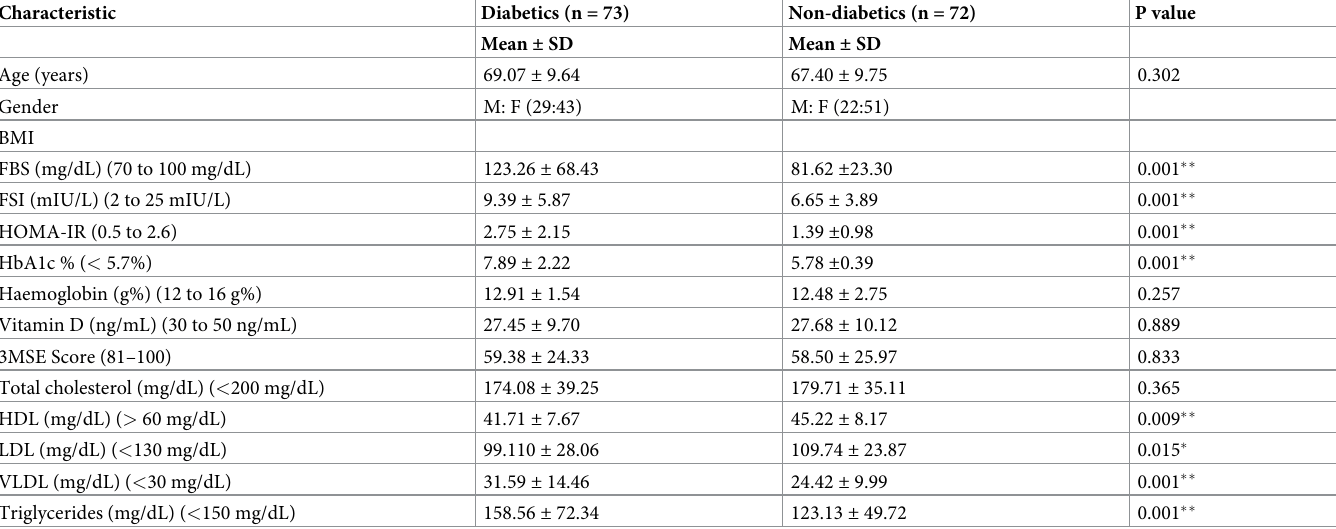
Table 1. Comparison of study participant characteristics between diabetic and non-diabetic groups.